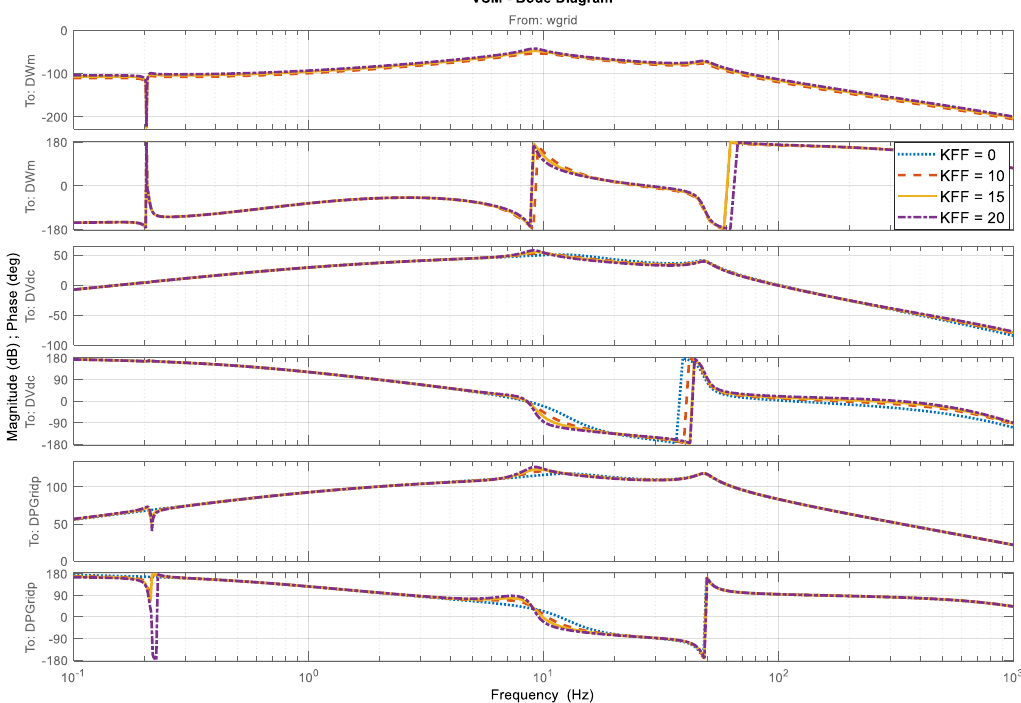
Figure 25. VSM Bode plot showing the effect of inertia feedforward to the generator.